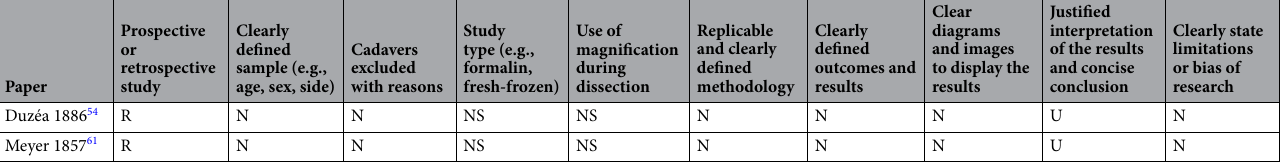
Table 2. Table of the critique of the literature. A quality analysis of papers included in this review was performed using a modified quality assessment tool for macroscopic anatomical studies, adapted from Henry